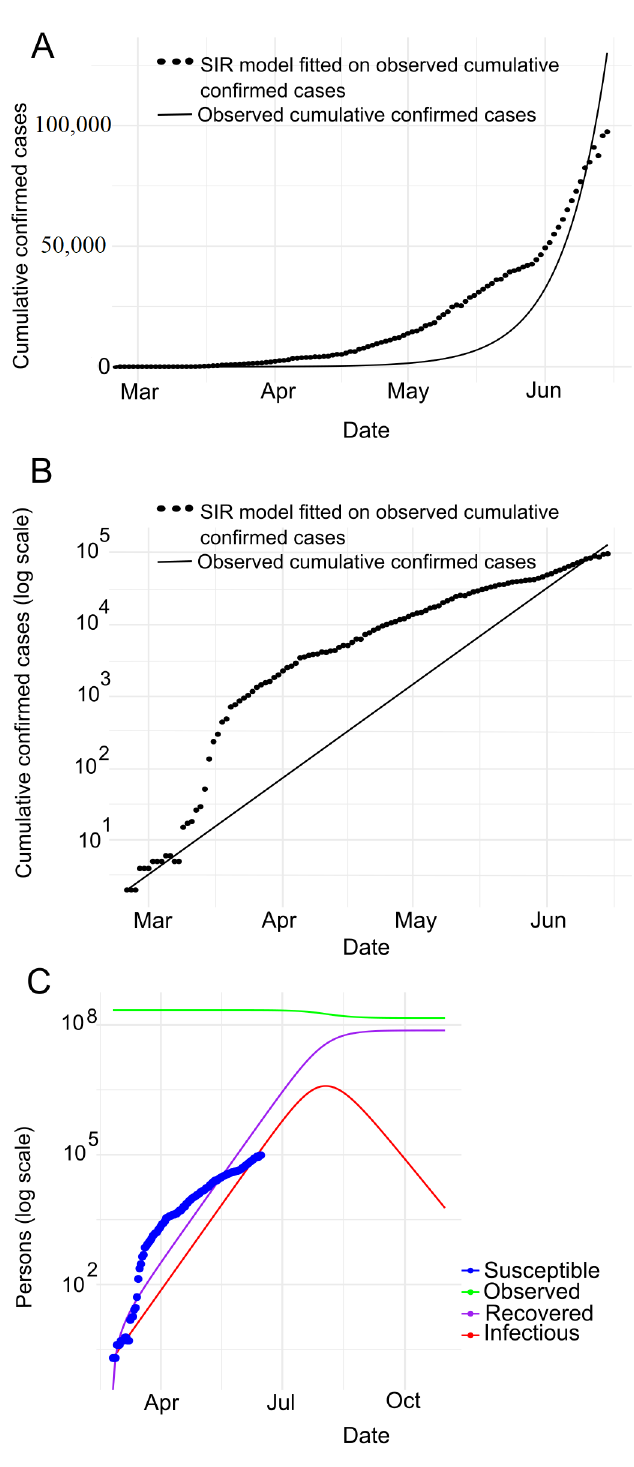
Figure 6. Prediction with SIR model for Pakistan: ( A ) SIR model fitted on observed cumulative infected cases ( B ) SIR model fitted on observed cumulative infected cases with semi log scale ( C ) SIR model prediction with no human